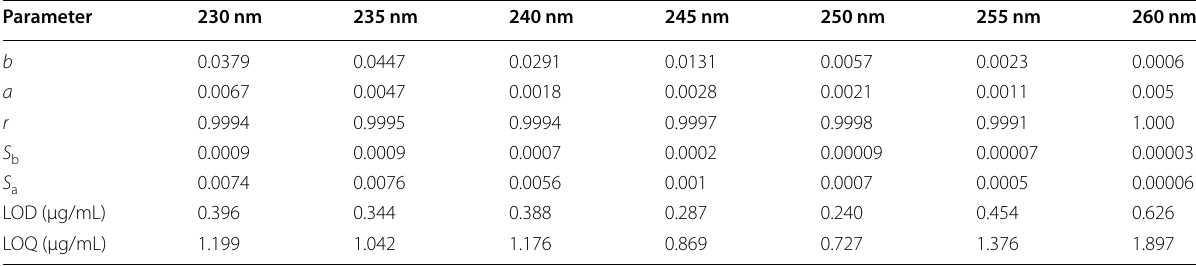
b slope, a intercept, r correlation coefficient, S b standard deviation of the slope, S a standard deviation of the intercept, LOD limit of detection, LOQ limit of quantitation Table 2 Atorvastatin linearity data (multiwavelength regression method) Parameter